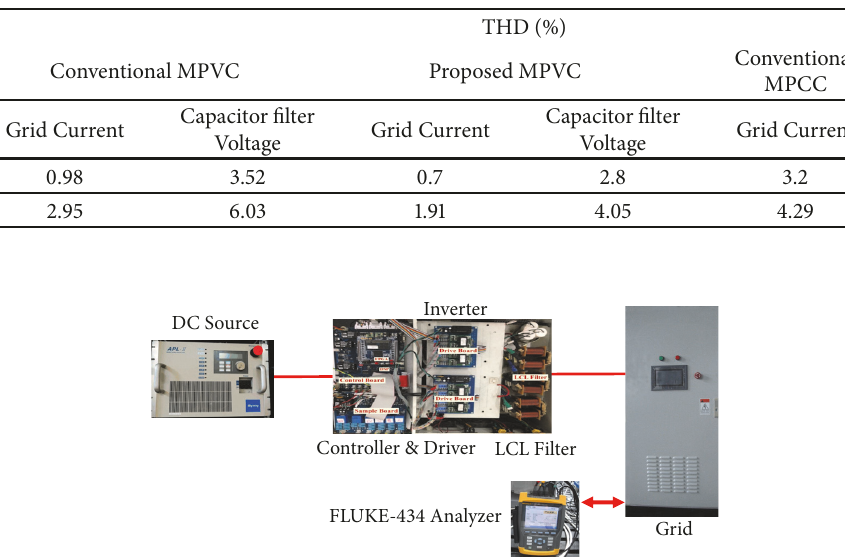
Figure 14: Laboratory setup.